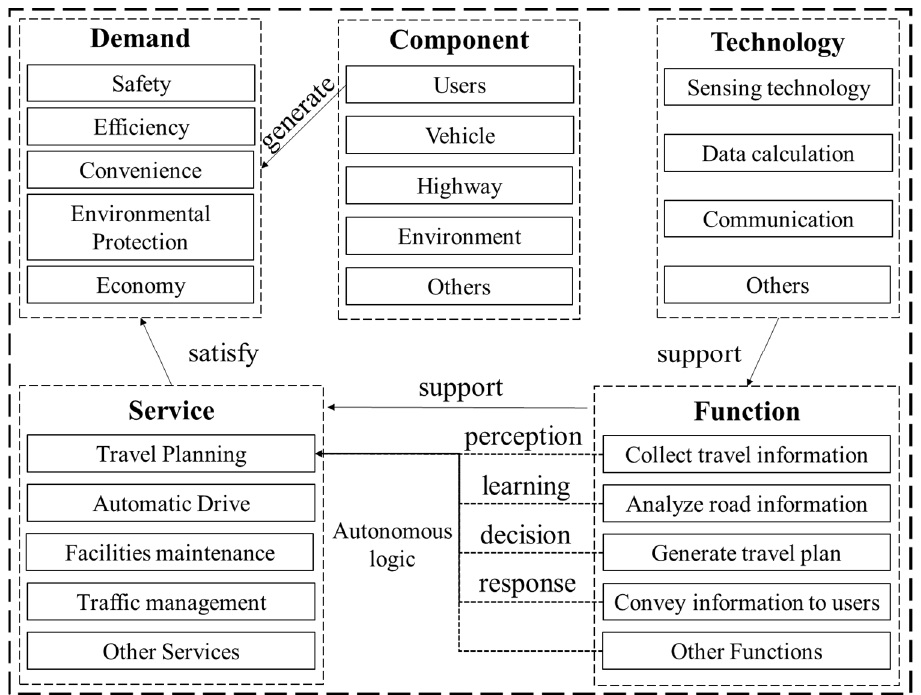
Figure 1. The relationship among ATS elements in a trip.